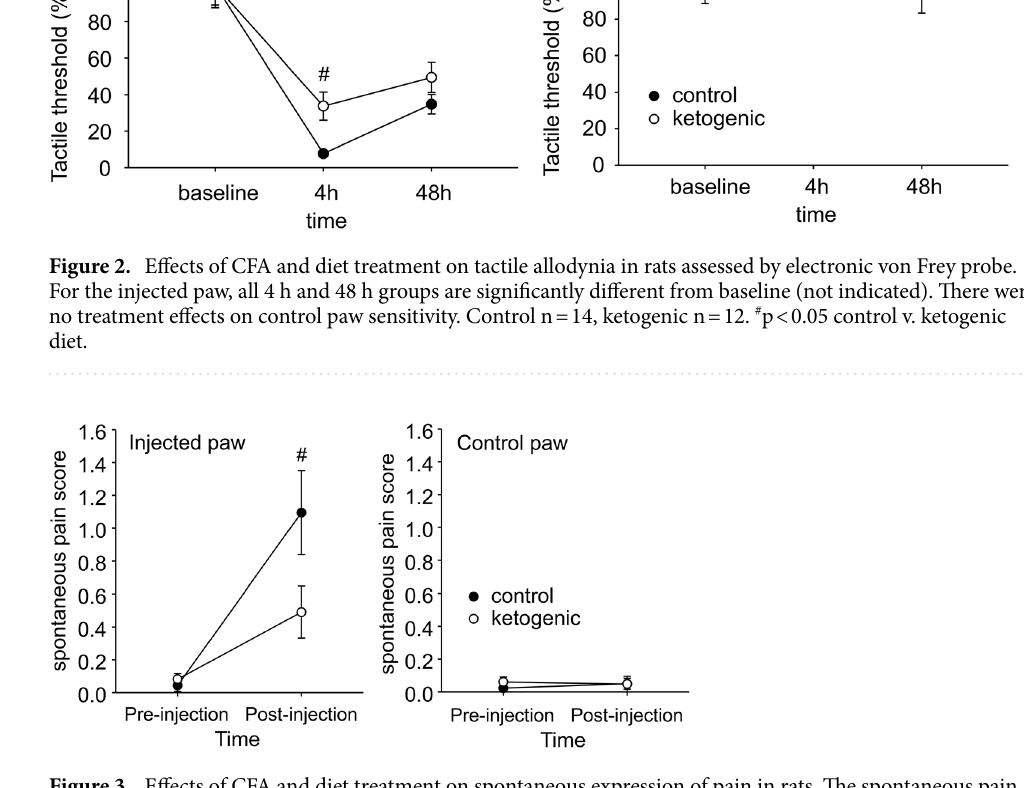
Figure 3. Effects of CFA and diet treatment on spontaneous expression of pain in rats. The spontaneous pain score was calculated from observations on paw favoring, lifting, and licking before and 24 h after CFA injection. For the injected paw, spontaneous pain was significantly higher compared to pre-injection for both groups (not indicated). However, there was a strong trend for spontaneous pain to be lower in ketogenic diet-treated rats. There were no effects regarding the uninjected paw. Control n = 14, ketogenic n = 12. # p =